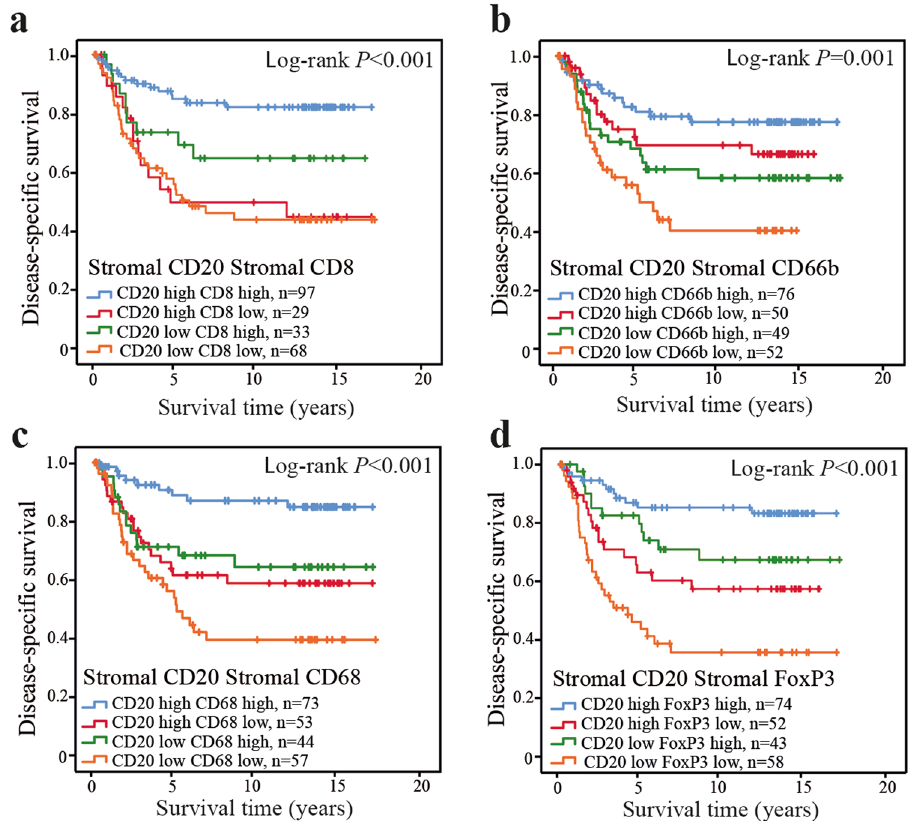
Figure 3. Prognostic relation of CD20 + cells to different immune cell subsets in CRC. Cases scored for subgroups of CD20 high or low together with; ( a ) CD8 high or low; ( b ) CD66b high or low; ( c ) CD68 high or low; and ( d ) FoxP3 high or low, in the tumour stromal compartment as indicated. Shown are Kaplan-Meier plots. Log-rank tests were used to calculate P